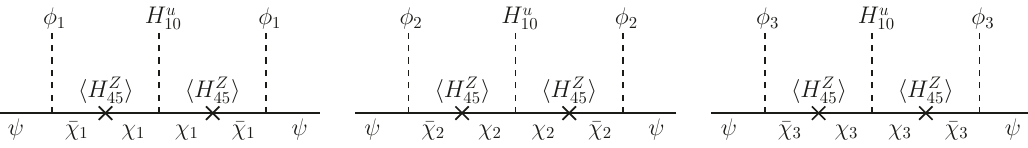
Figure 1 . Diagrams coupling